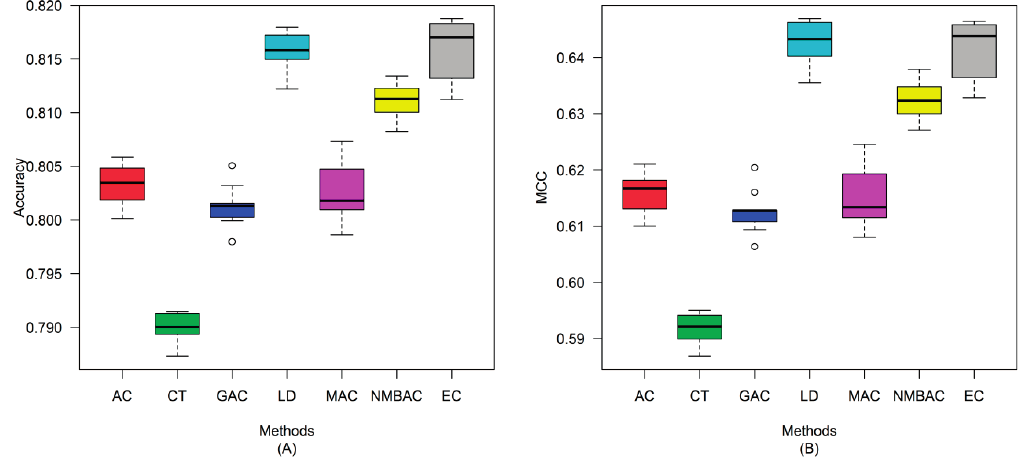
Figure 16. Average accuracy and MCC of different methods on the Silver Human dataset with five-fold cross-validation. ( A ) Accuracy; ( B ) MCC.